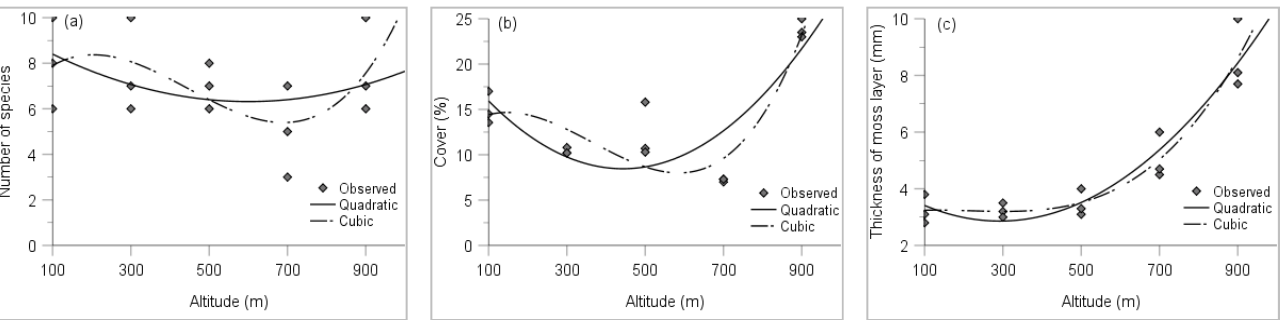
Figure 2. Characteristics of terrestrial moss distributed along the elevation gradient; ( a ): species richness along elevational gradient; ( b ): cover of terrestrial moss species along elevational gradient; ( c ): thickness of moss layer along elevation gradient.